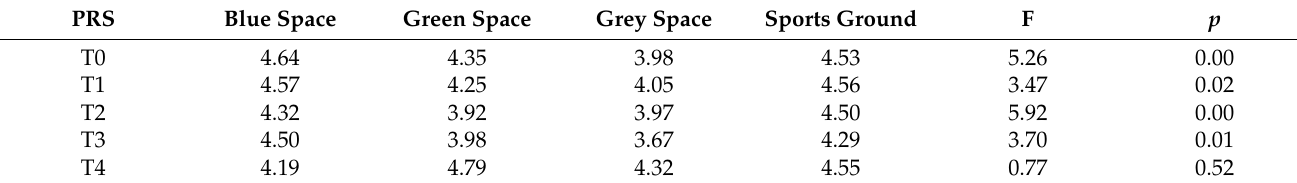
Table 4. ANOVA results of recovery under different environments at five time points. PRS Blue Space Green Space Grey